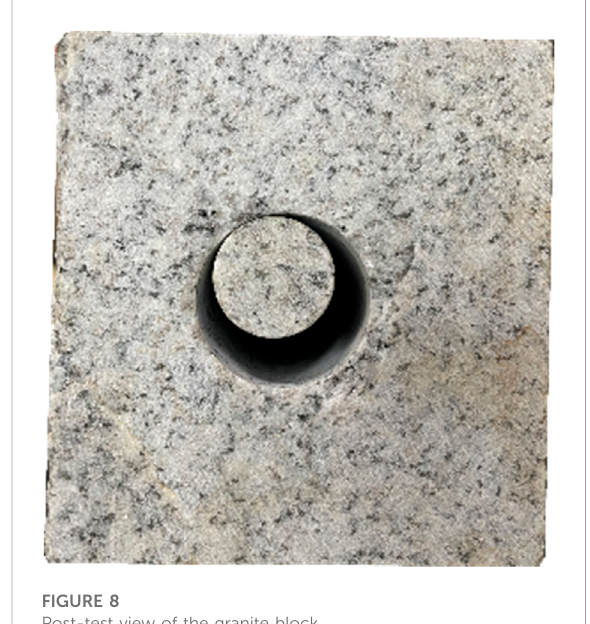
FIGURE 8 Post-test view of the granite